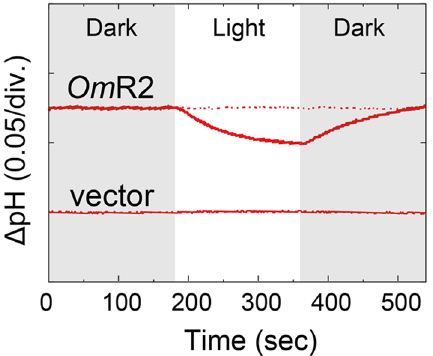
Figure 3. Outward proton pump activity of Om R2 in E. coli cells. Light-induced pH changes of solutions containing E. coli cells with the expression plasmid for Om R2 (upper panel) or the empty vector pET21a (lower panel) in the presence (red dashed lines) or absence (red solid lines) of the proton-selective ionophore, CCCP (10 µM). The initial pH ranged from 6.4 to 6.6. The white-filled region indicates the period of